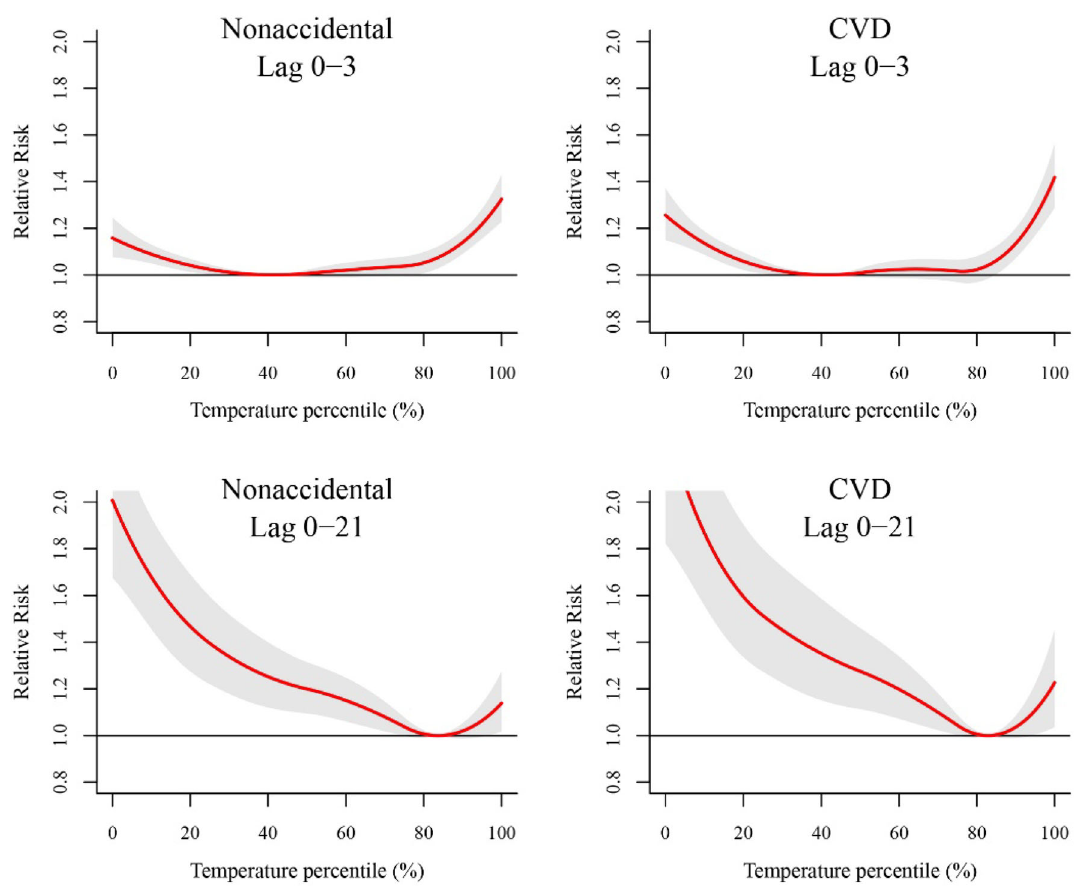
Fig. 3 Pooled effects of temperature on nonaccidental and cardio- vascular disease (CVD) mortality with 0–3 and 0–21 lag days from 25 counties/districts in BTH, YRD, and PRD, with reference to mortality